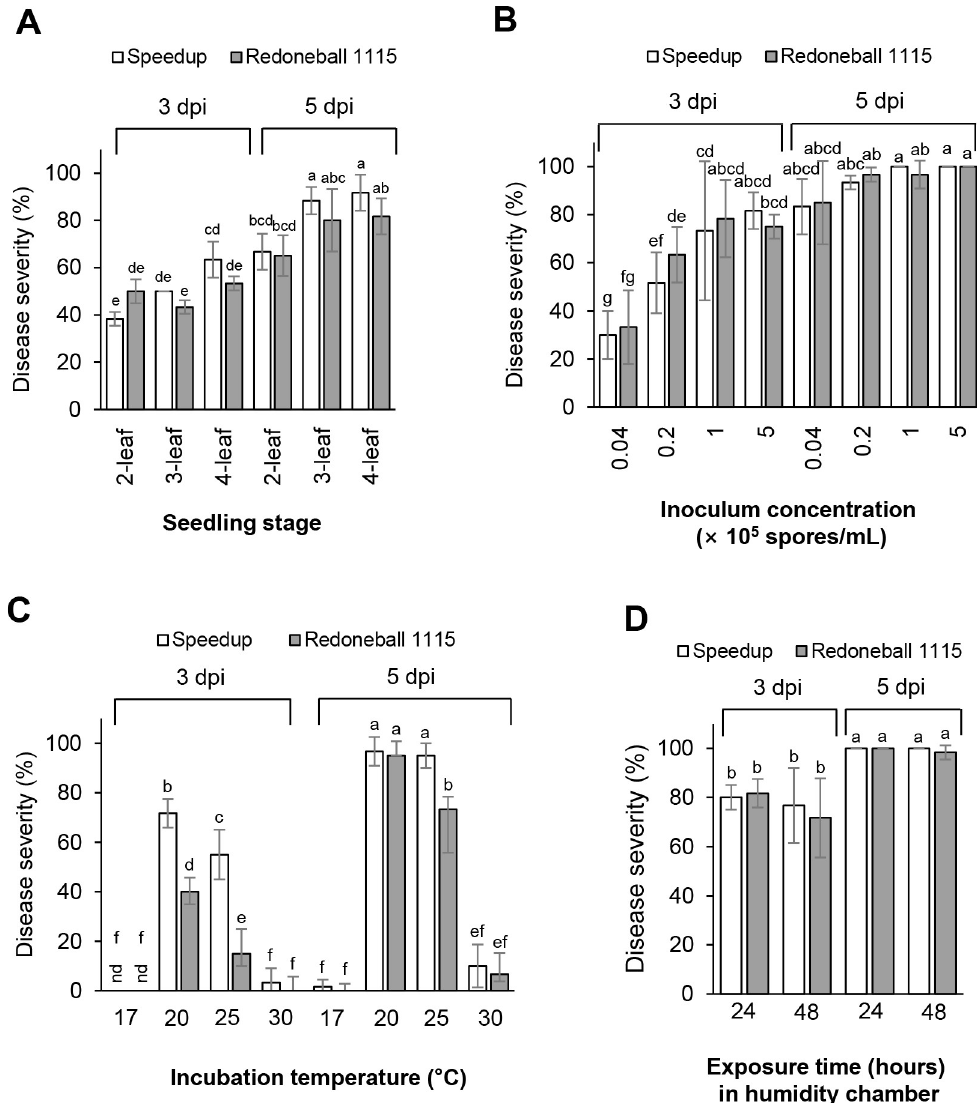
Fig 2. Disease development of onion purple blotch. Effects of leaf stage (A), inoculum concentration (B), temperature (C), and humidity (D) on the development of onion purple blotch. As host plants, two onion cultivars Speedup and Redoneball 1115 were used for the assay. The bars represent the mean ± standard deviation of two runs with three replicates. Different letters indicate significant differences at p < 0.05.